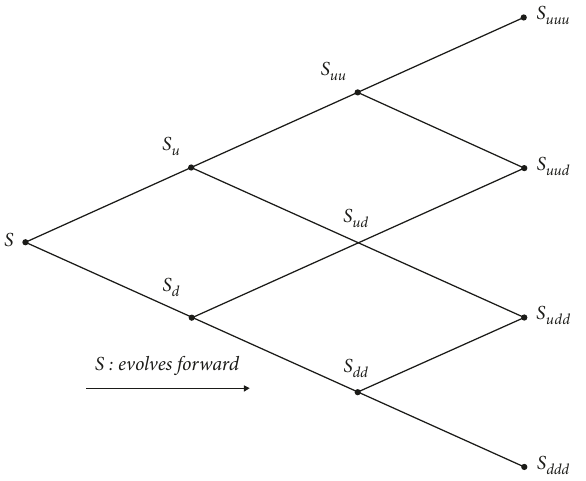
Figure 4: Binomial tree for the underlying asset distribution (forward